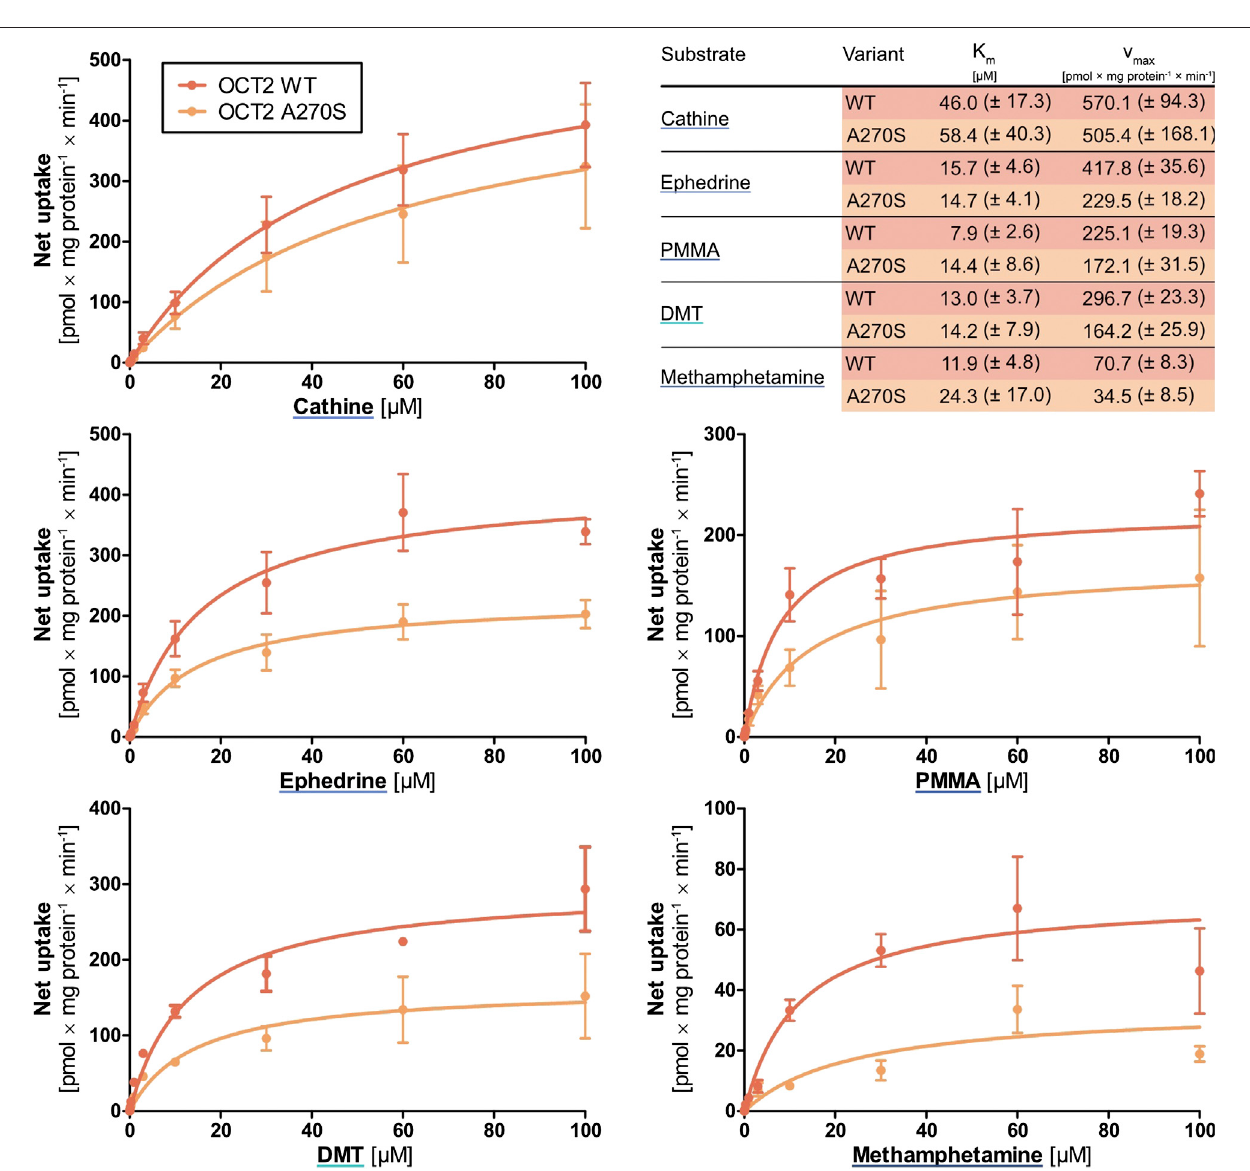
FIGURE 5 | Transport of cathine, (-)-ephedrine, PMMA, DMT, and methamphetamine at different concentrations by wild-type OCT2 (red) and the variant A270S (orange),shownasthecellularuptakeintransporter-overexpressingcellswithsubstracteduptakeinnon-overexpressingcontrolcells.Shownarethemeanvaluesof ≥ 3 independent experiments ±